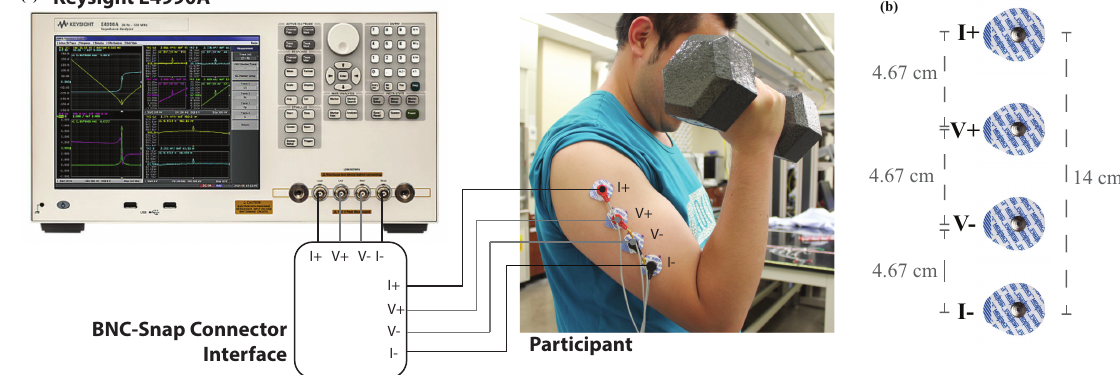
Figure 2. ( a ) Experimental test-setup to collect measurements from study participants using Keysight E4990A impedance analyzer using ( b ) tetrapolar electrode